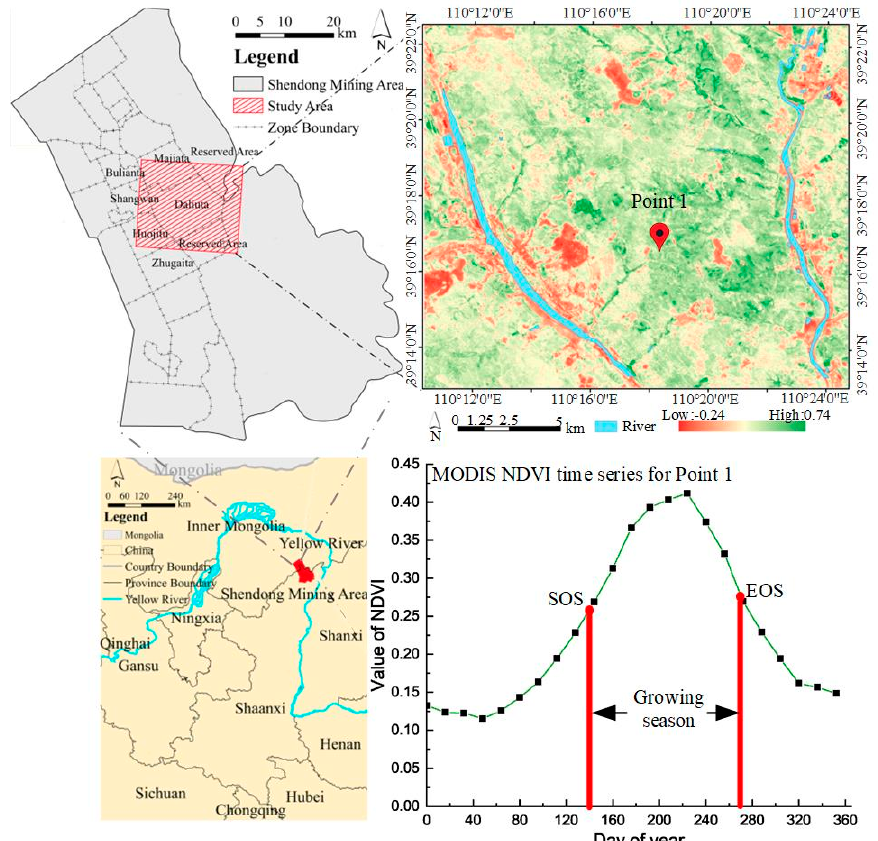
Figure 2. Location of the experimental area in the Shendong mining region. The normalized difference vegetation index (NDVI) was calculated by using a Landsat image (scene ID: LE07_L1TP_127033_20170730_20170825_01_T1_ANG). The phenology curve was extracted from the The Terra Moderate Resolution Imaging Spectroradiometer (MODIS) Vegetation Indices (MOD13Q1) NDVI time series at point 1, where the SOS and the EOS represent the start of growing season and the end of growing season, respectively.